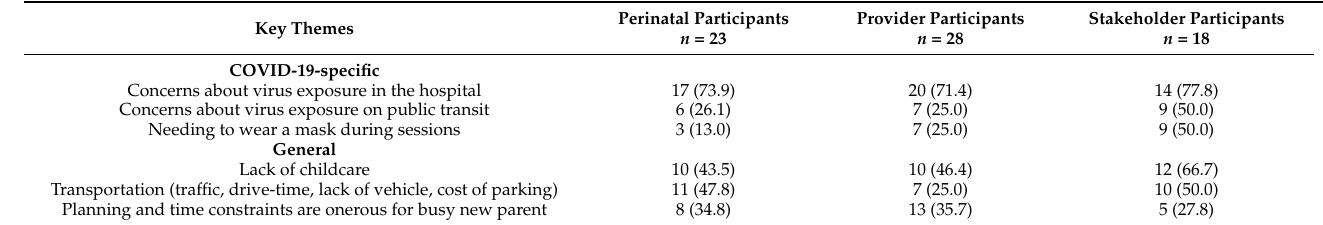
Table 2. Reported barriers to resuming in-person psychotherapy sessions, n